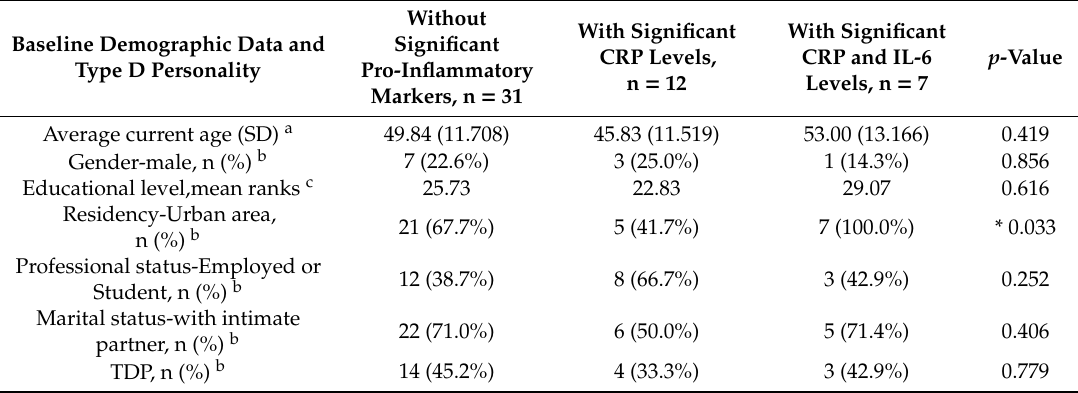
Table 1. Demographic characteristics of the studied group depending on the peripheral elevated pro-inflammatory